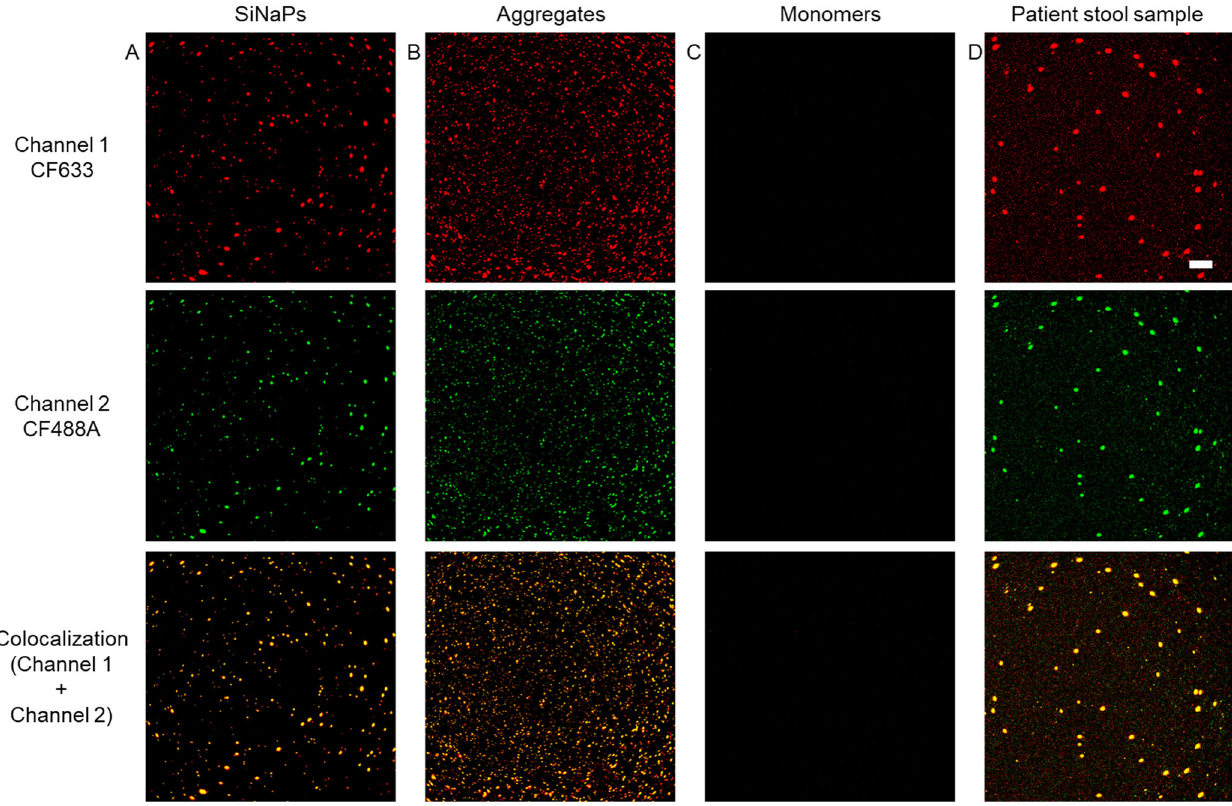
Fig. 2 Fluorescence images of α -synuclein SiNaPs, synthetic α -synuclein aggregates, monomers, and a PD stool sample. Shown are exemplary fl uorescence images taken in the red fl uorescence channel (channel 1, CF633), green fl uorescence channel (channel 2, CF488A), and the colocalized fl uorescence signal of both channels of a 0.32 pM α -synuclein SiNaPs in buffer b 1581 pM synthetic α -synuclein aggregates in buffer (concentration based on the deployed monomer concentration), c 1000 pM α -synuclein monomers in buffer, and d a stool sample of a PD patient. To better visualize the 16-bit images, the contrast and minimum/maximum values were adjusted. Scale bar: 30 patients and healthy controls in Supplementary Table 1. There was a gender bias towards men in the PD (69.1%) and more so in the